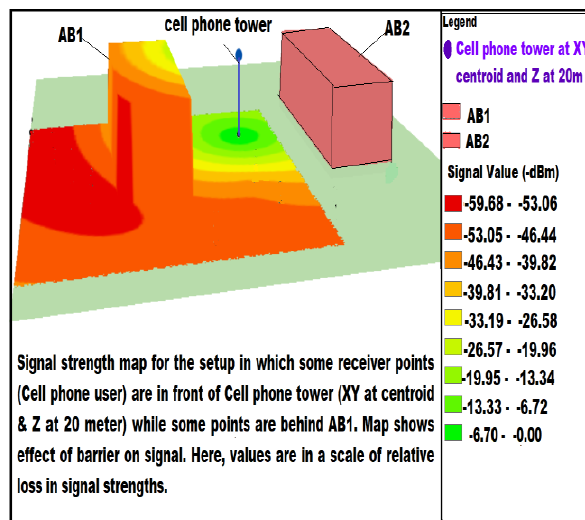
Figure 26. 3D signal strength map showing the effect of barrier on a signal when cell phone tower (XY at the centroid, Z at 20